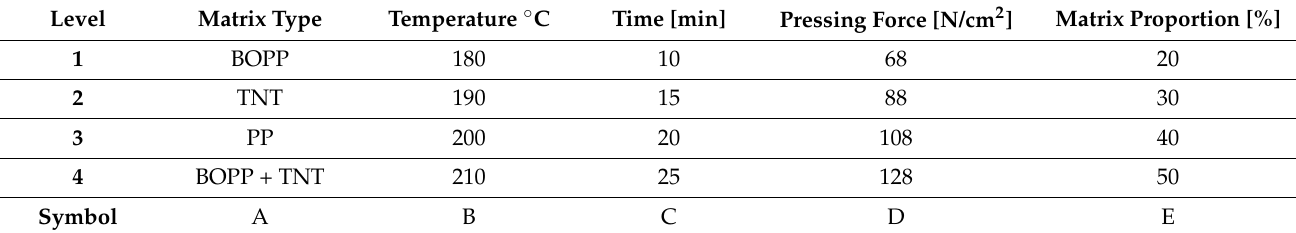
Table 1. Signal parameters